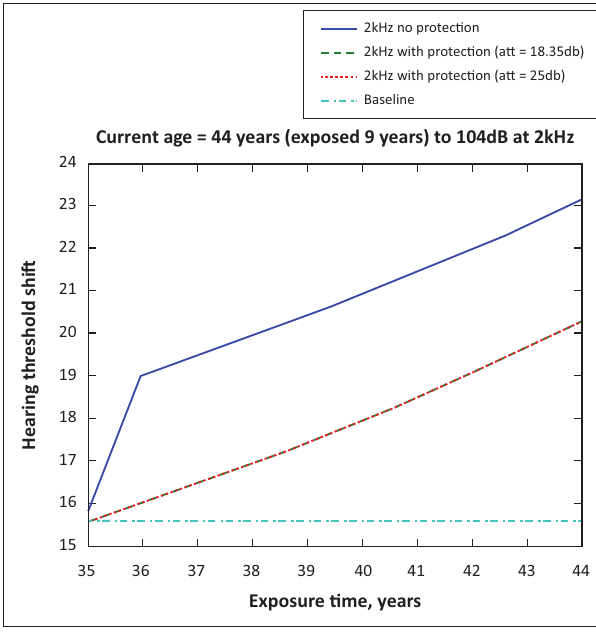
Source : Figure created using data from Moroe, N.F. (2018). Occupational noise-induced hearing loss in South African large scale mines: From policy formulation to implementation and monitoring . Doctoral thesis. Johannesburg: University of the Witwatersrand. FIGURE 2: Forty-four years old at 2000 Hz with exposure levels of 104